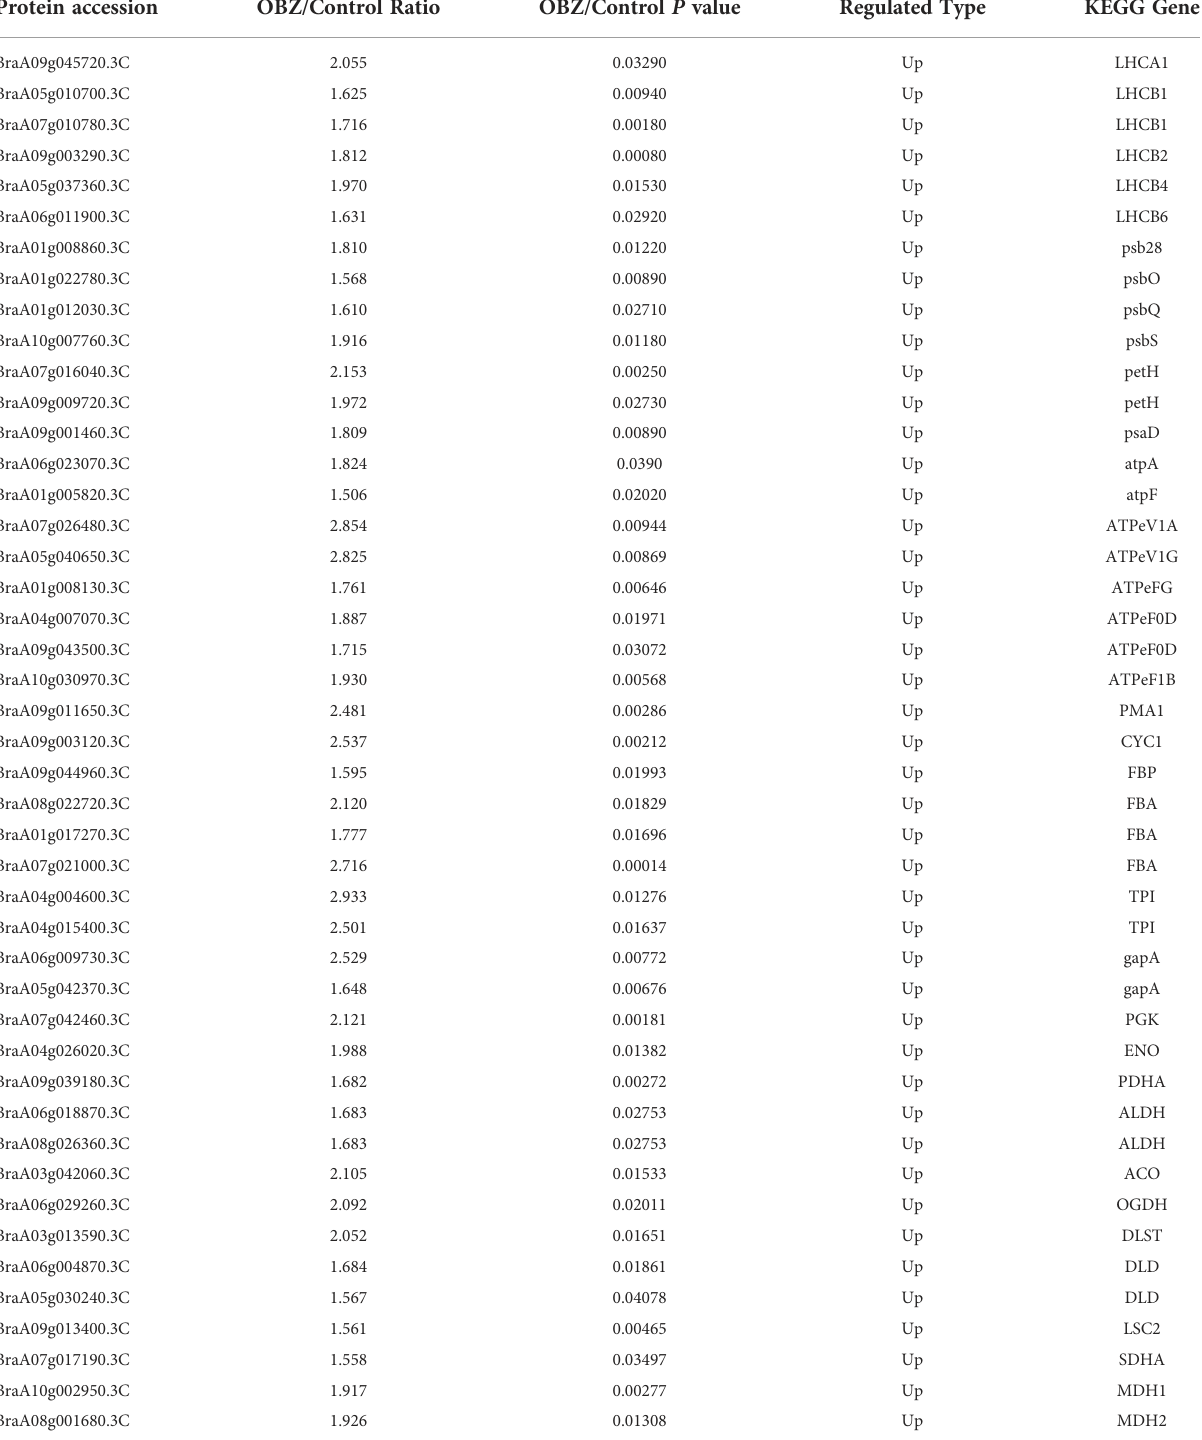
TABLE 2 Differentially modi fi ed sites (modi fi ed proteins) for photosynthesis and carbon metabolism. Protein